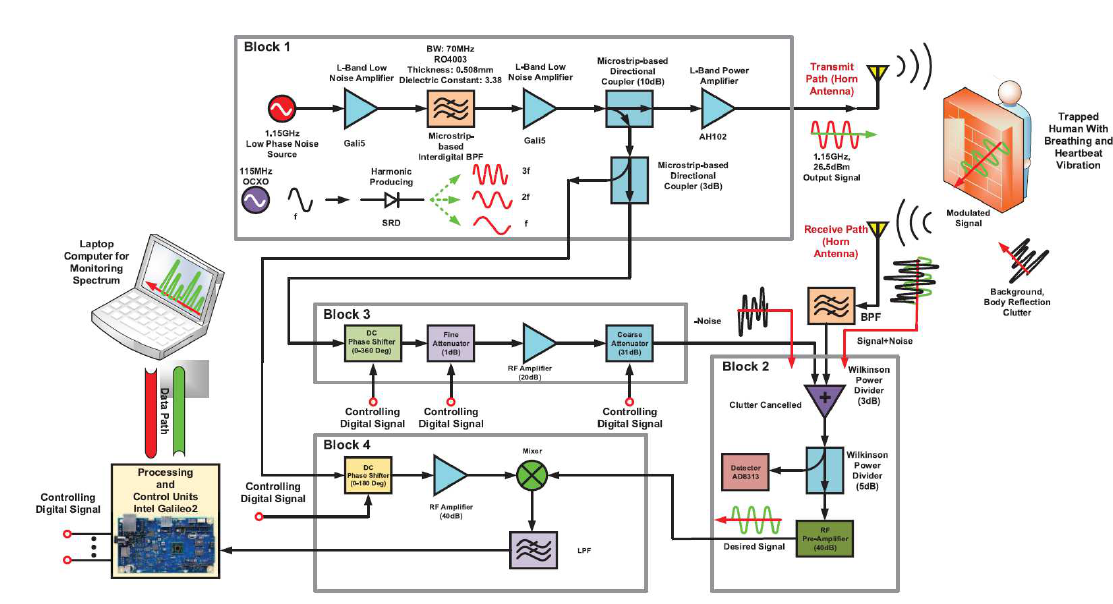
Figure 8. Schematic of the life-detector system [92].